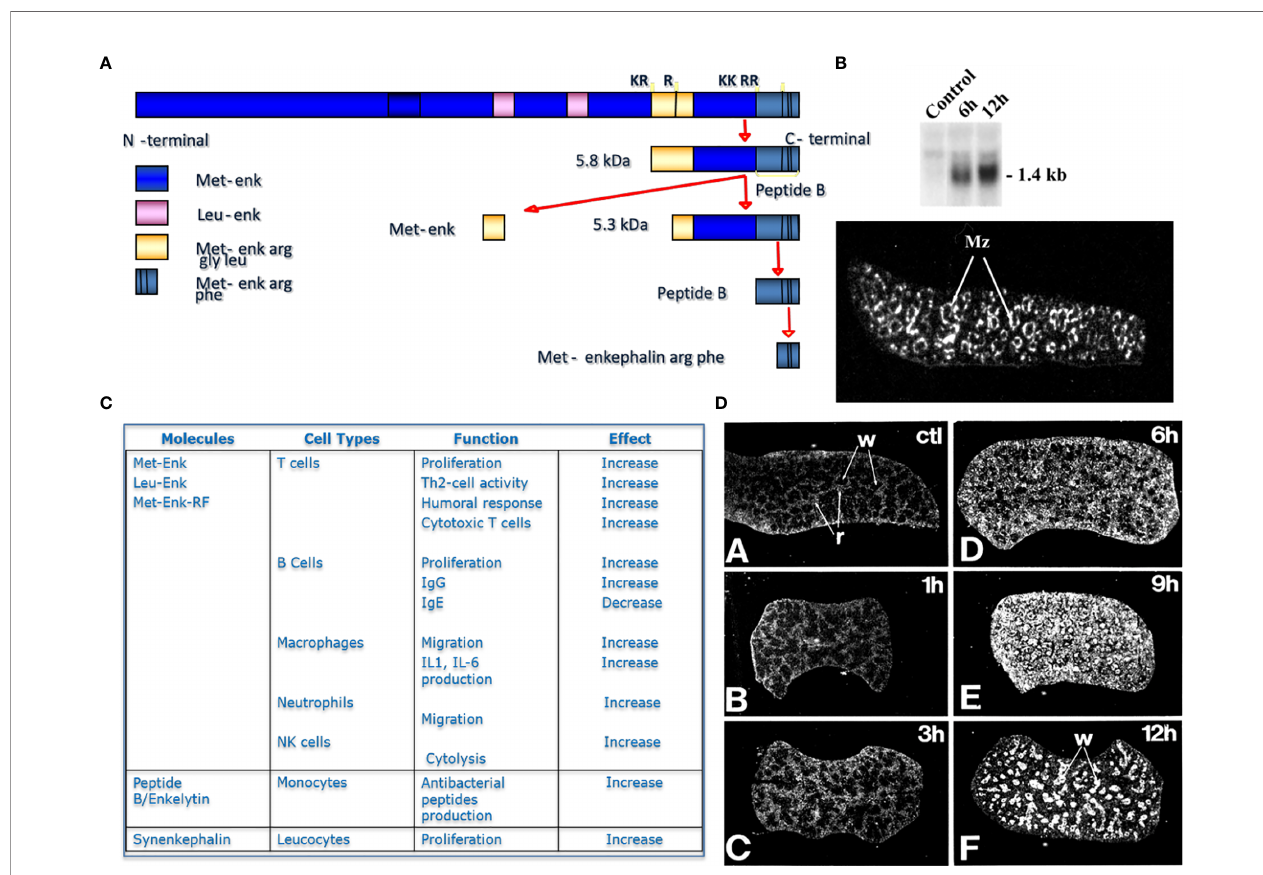
FIGURE 1 | Proenkephalin and proprotein convertases in immune cells. (A) Scheme of Proenkephalin cleavage by PCs in macrophages, (B) Expression of proenkephalin in spleen with or without LPS treatment in time course, inset photograph representing the expression of proenkephalin in spleen ‘ marginal zone after 12h LPS treatment, (C) Table of the immune action of the enkephalins on immune cells, (D) identi fi cation of PC1/3 expression in rat spleen in time course after LPS